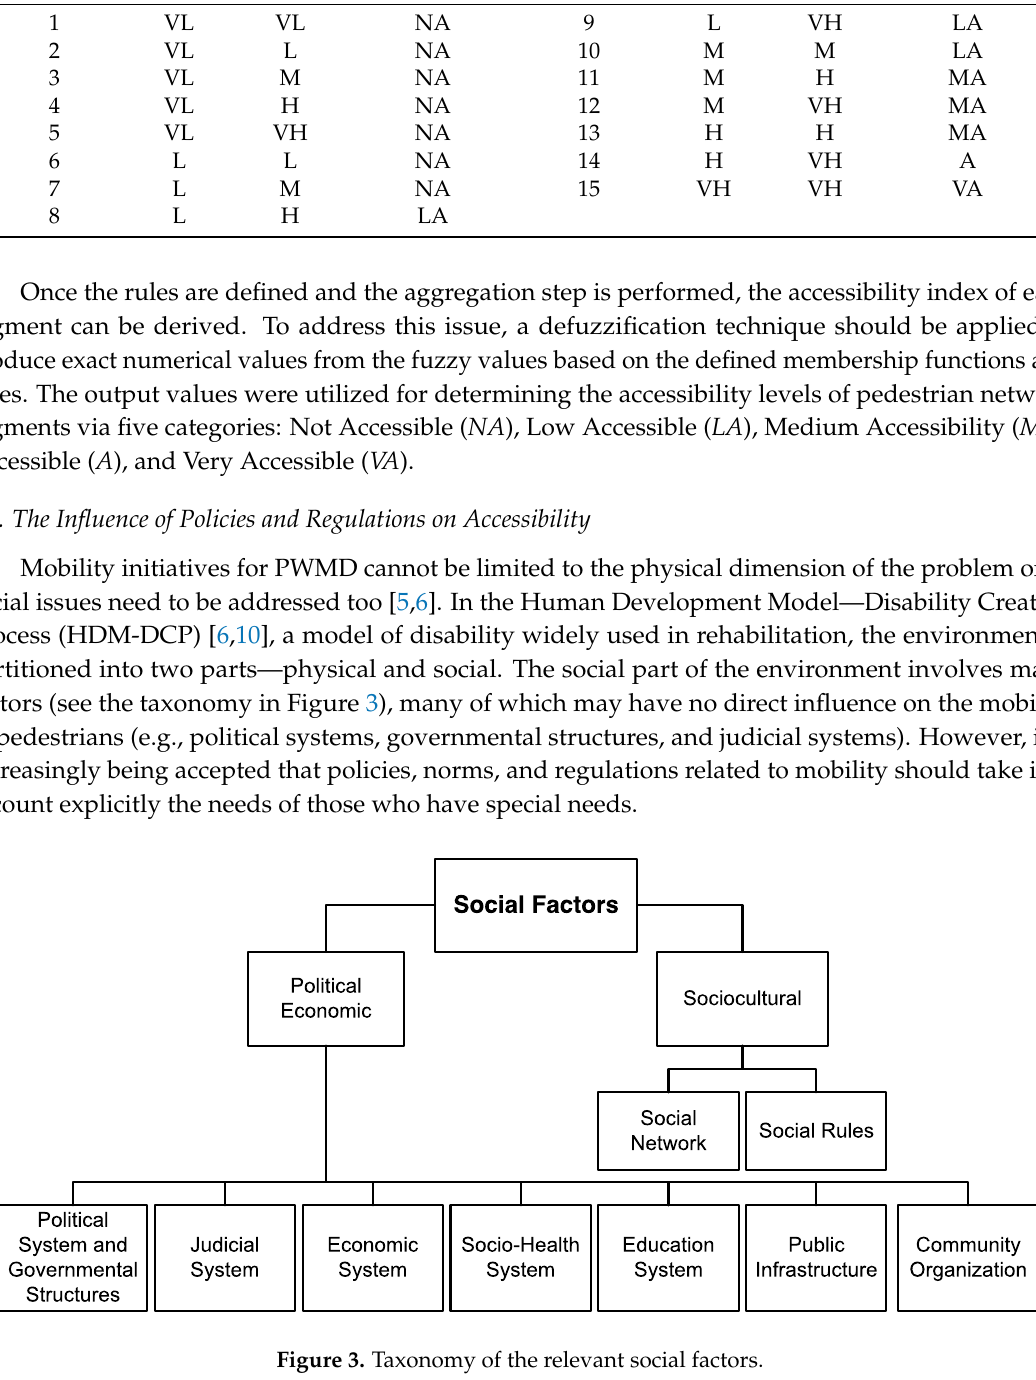
Figure 3. Taxonomy of the relevant social factors.